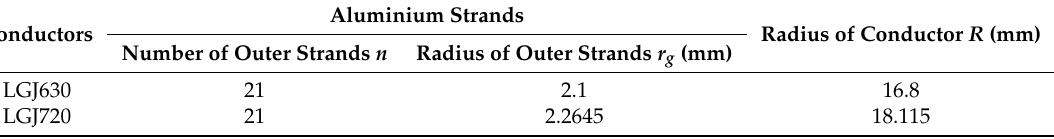
Table 1. Parameters of two common stranded conductors.